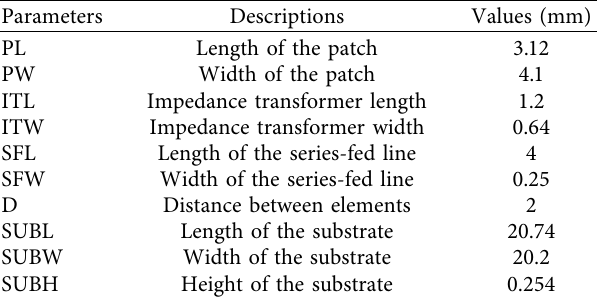
3 mm including feed lines and decoupling networks were confgured (Figure 3) and simulated using the software ADS.